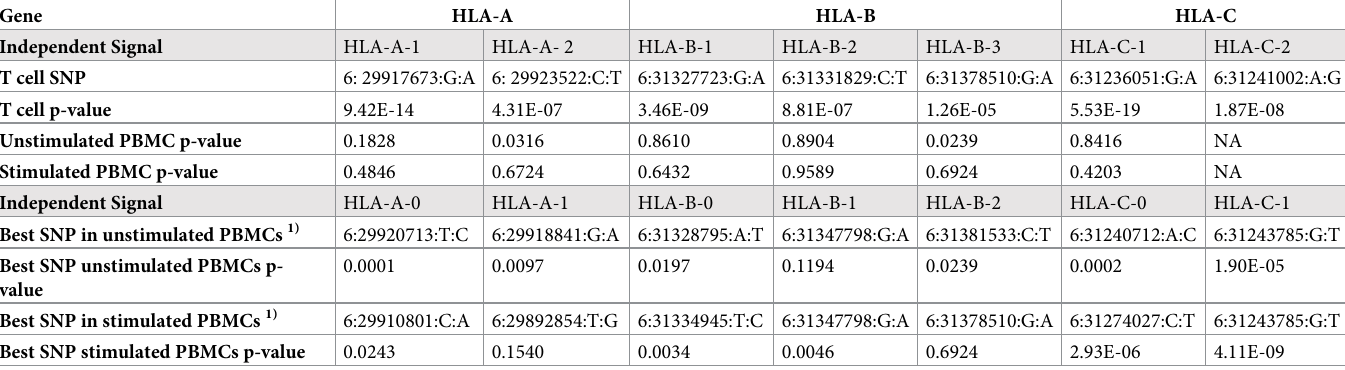
Table 2. Best eQTL SNPs shared between T cells and